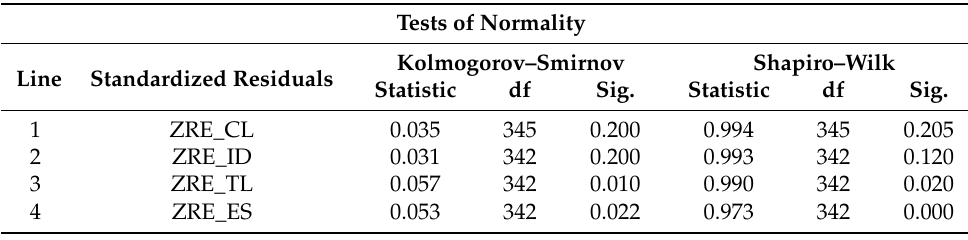
Table 8. Standardized residuals normality